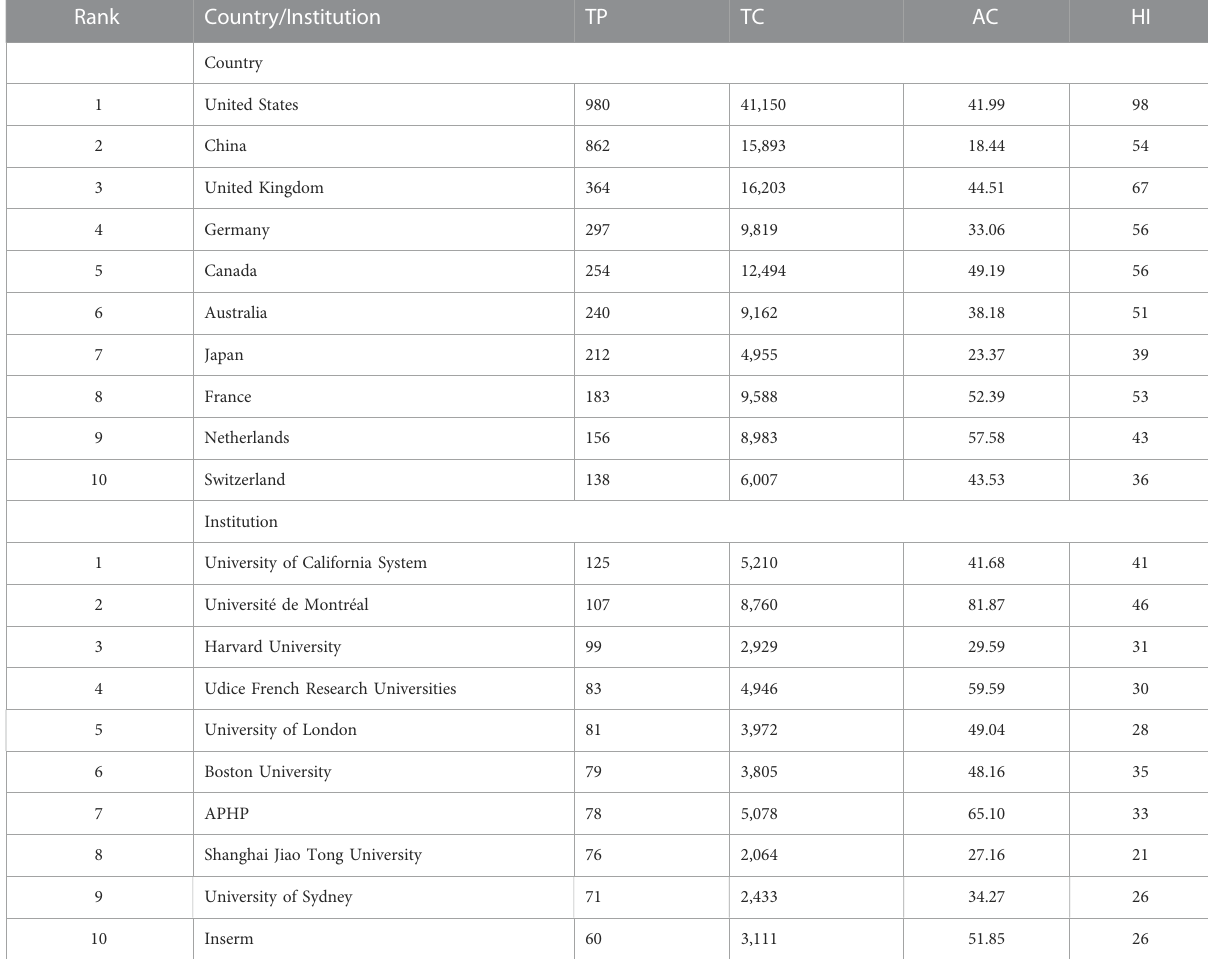
TABLE 1 Top 10 countries and institutions with the most